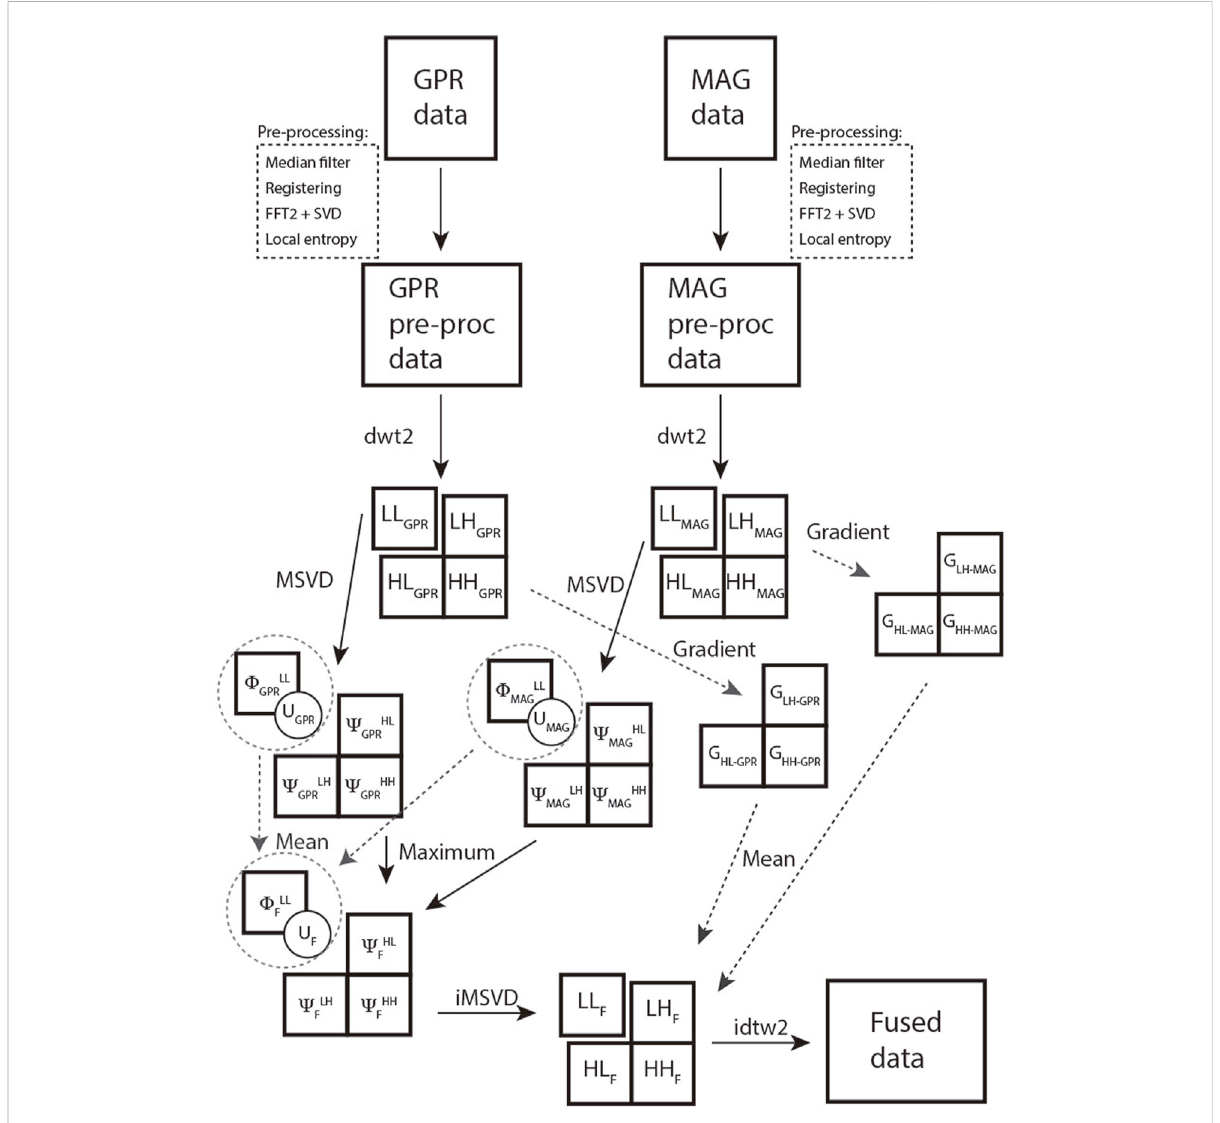
Frontiers in Earth